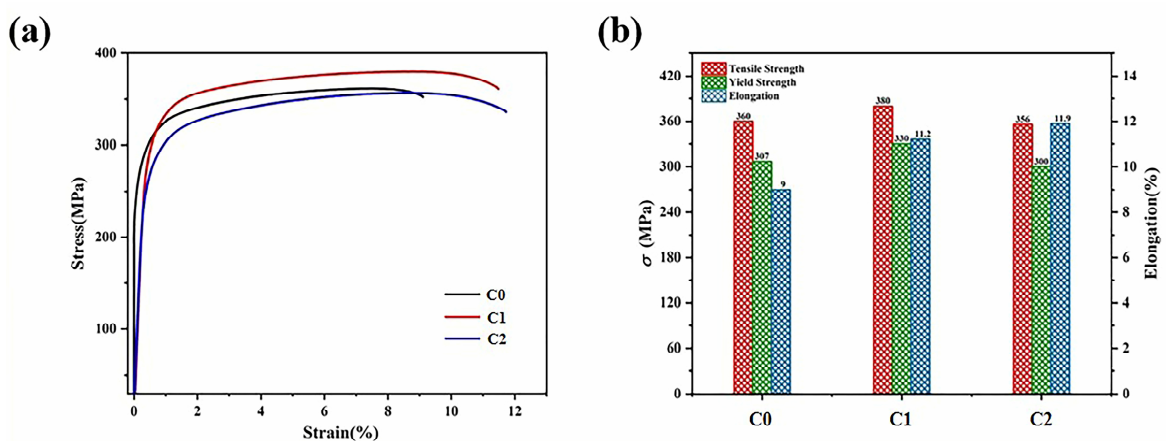
Figure 10. Room temperature tensile properties of as-extruded Al-9.5Si-1.5Cu-0.8Mn-0.6Mg alloy ( a , b ).